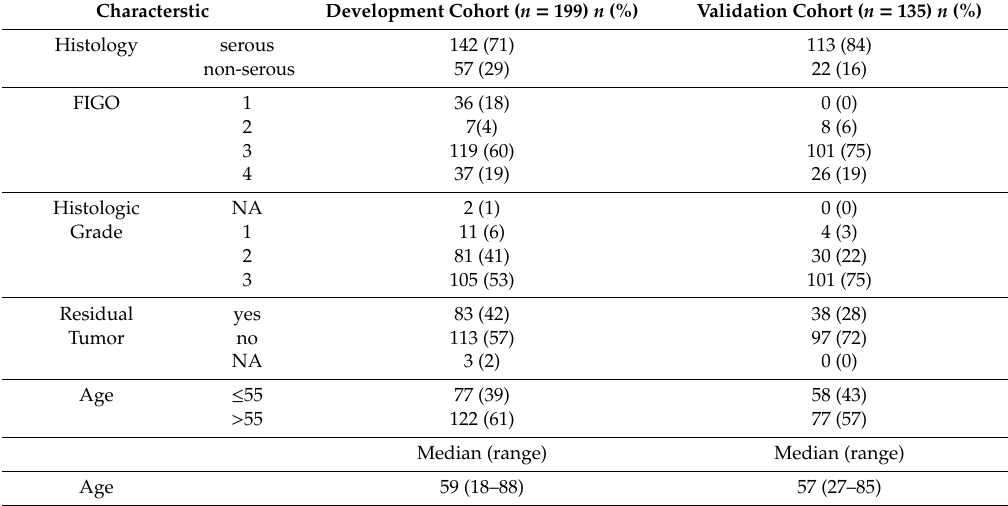
FIGO: F é d é ration Internationale de Gyn é cology et d’Obst é trique; NA: not